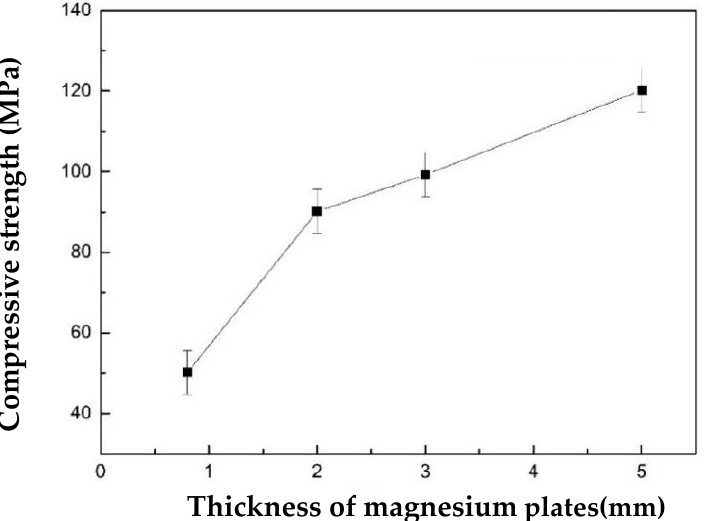
Figure 14. Quasistatic compression of sandwiched magnesium syntactic foam with different thick- nesses of the two side plates.